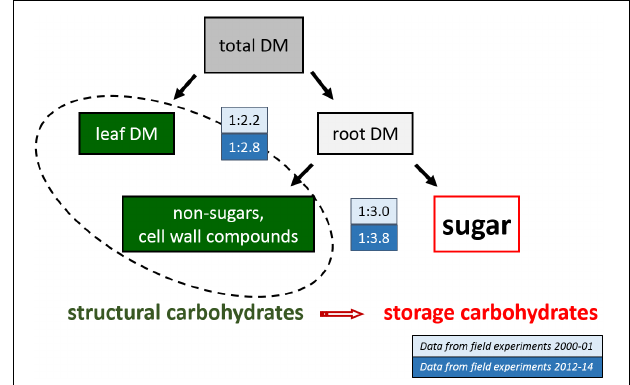
FIGURE 1 | Shift in assimilate partitioning in sugar beet due to breeding progress based on data from 27 field experiments in Germany, 2000–2001 and six field experiments with three sowing dates and two varieties in 2012–2014. DM, dry